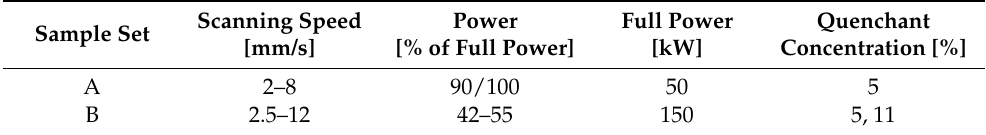
Table 1. Induction hardening settings of the two test sets, set A and